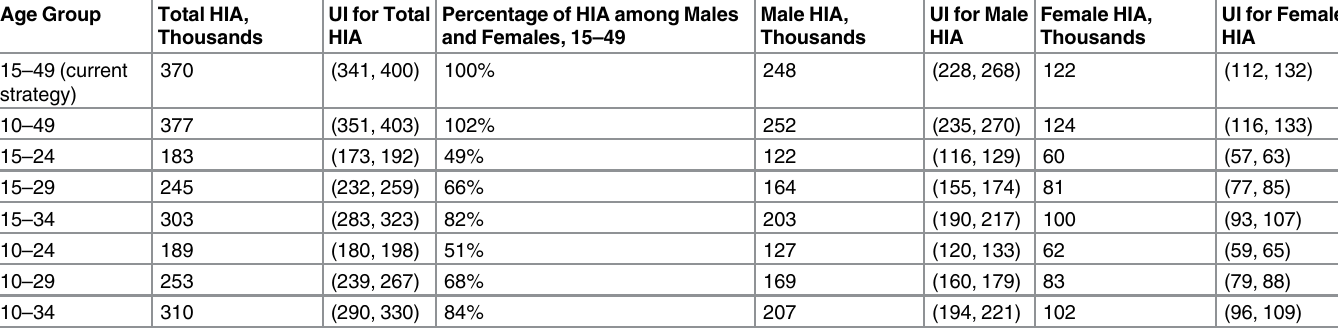
Table 1. HIV Infections Averted (2014 – 2028) in Scenarios Scaling Up VMMC among Indicated Age Groups.